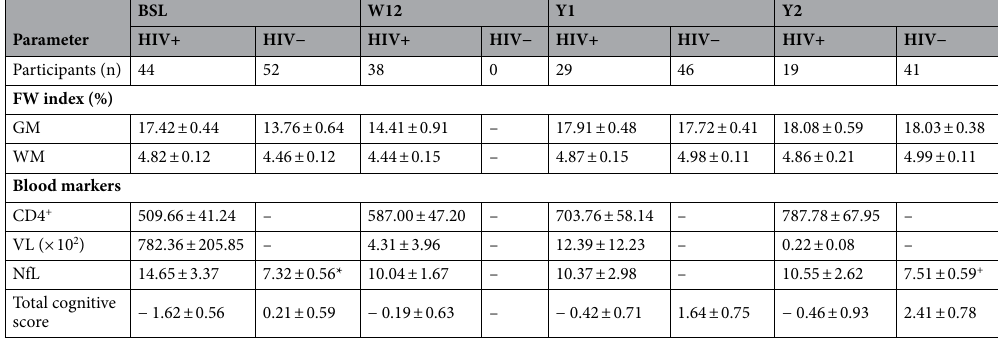
Table 2. Extracellular free water, blood markers and cognitive data at baseline and follow-up visits. Values are Mean ± Standard Error; Units: Free Water, FW in %; Viral Load, VL in copies/mL; CD4 + T cell in count/ mm 3 ; Neurofilament Light Chain, NfL in pg/mL; grey matter, GM; white matter, WM; —indicates data are not available. *Indicates n = 15. + Indicates n =